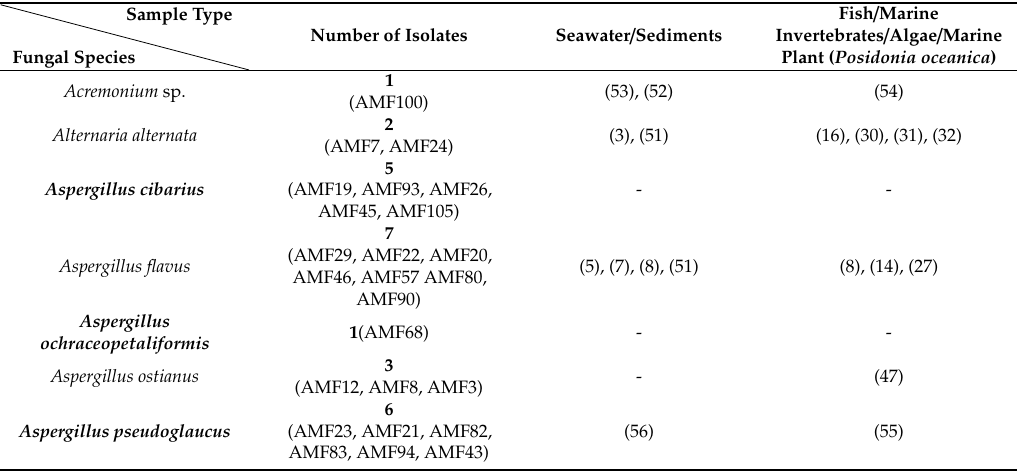
Table 1. List of fungal isolates and their taxonomic a ffi liation depending on several genetic markers. Species highlighted for the first time in the marine environment are in bold and those highlighted for the first time in seawater are in bold with a